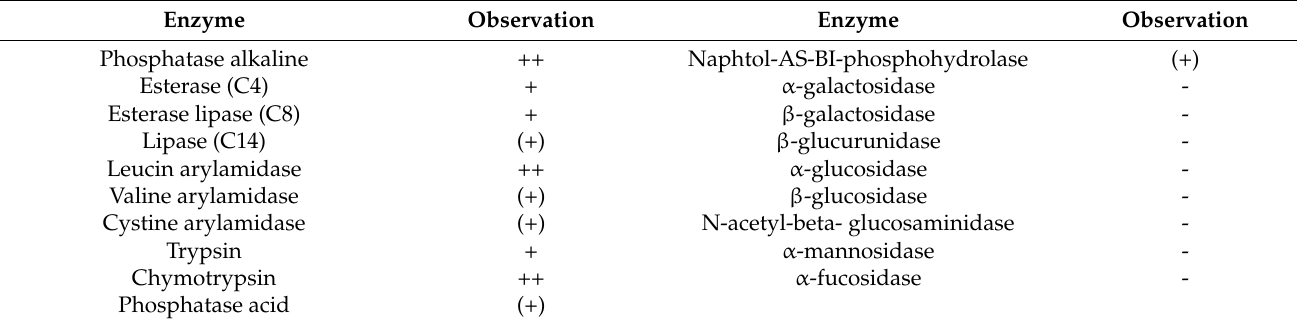
Table 2. Different enzymes produced by strain WHA3 T detected by the ApiZym system.